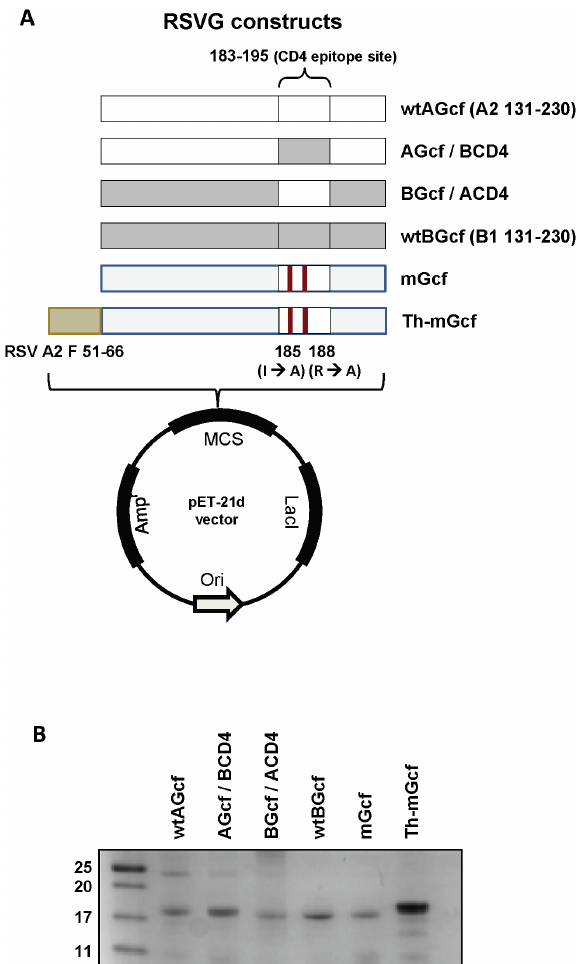
Figure 1. Construction of plasmids expressing various Gcf proteins and purified proteins. (A) wtAGcf, AGcf/BCD4, BGcf/ACD4, wtBGcf, mGcf or Th-mGcf genes were cloned into pET21d vector to express recombinant Gcf proteins in E. coli (B) The proteins expressed in E. coli were purified by His-tag affinity chromatography and separated by 15% SDS-PAGE.